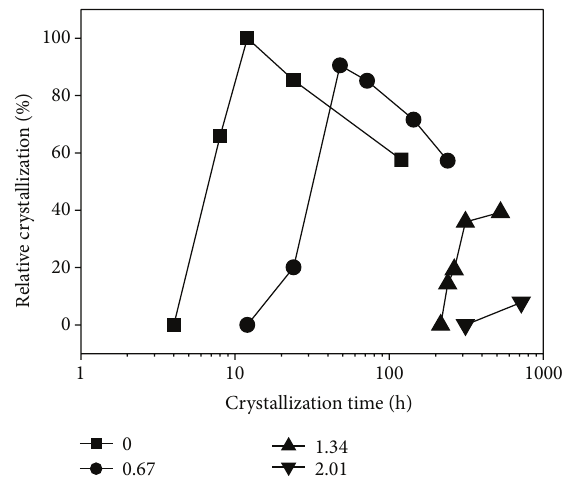
Figure 2: The relation of relative crystallinity and crystallization time with different H 2 SO 4 /Al 2 O 3 .